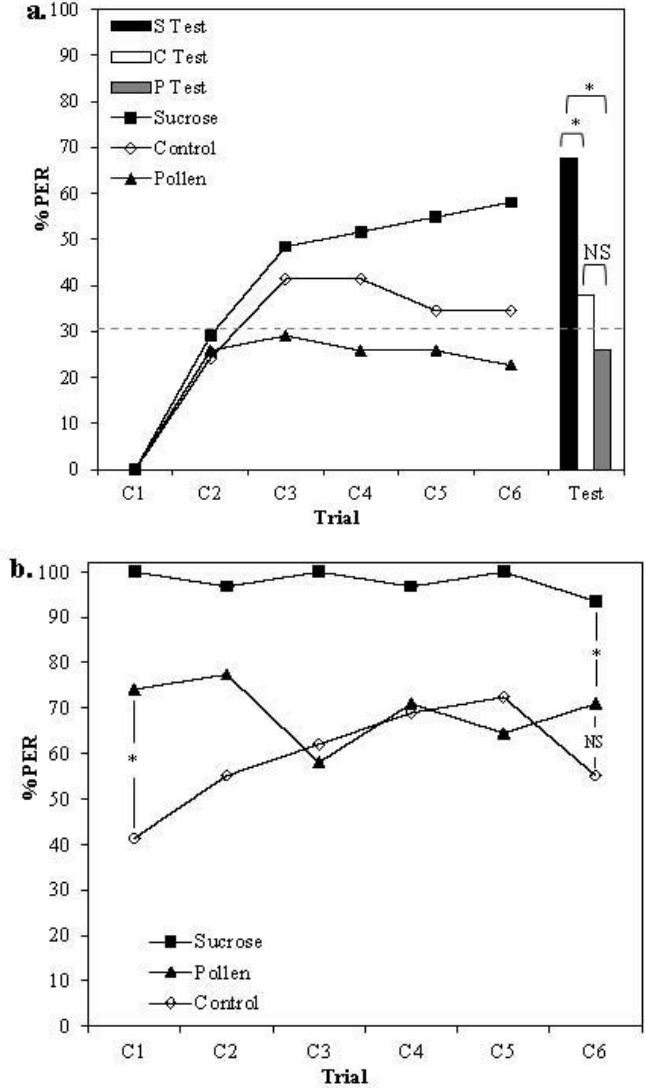
Figure 1. ( a ) Acquisition curves and ( b ) PER response to US stimulation of bees rewarded at the antennae only with 30% sucrose solution (Black squares, n = 31), dry pollen (Black triangles, n = 31) or a clean sponge (Open diamonds, n = 29). Bars represent the number of bees responding to the conditioned stimulus (CS) in the final, unrewarded test (Black = Sucrose, White = Control, Grey = Pollen). Dashed line represents the overall spontaneous response to the CS on the first trial for all bees tested. Asterisks denote significant differences between treatment groups (** p <0.001 * p